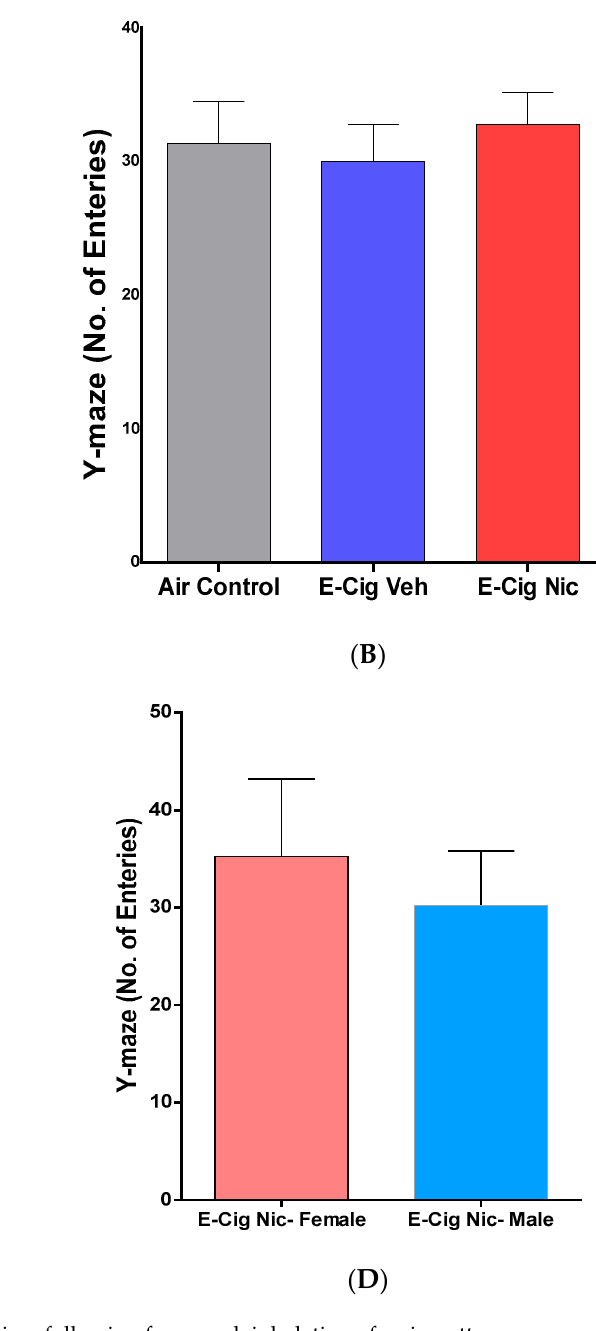
Figure 6. Spatial memory behaviors following four-week inhalation of e-cigarette vapors containing nicotine. ( A ) Percentage of spontaneous alterations (%SAP) (n = 8/group, 4F and 4M). ( B ) Number of entries into Y-maze arms (n = 8/group, 4F and 4M). ( C ) %SAP in female and male mice of the E-cig Nic group (n = 4/group). ( D ) Number of entries into Y-maze arms in female and male mice of the E-cig Nic group (n = 4/group). One-way analysis of variance (ANOVA) did not show significant differences between the three groups. Unpaired t test also did not reveal any significant changes in the Y maze parameters (%SAP and number of entries) between male and female of E-cig Nic group. Data are presented as mean ± SEM. E-cig, electronic cigarette; E-cig Veh, electronic cigarette with vehicle only; E-cig Nic, electronic cigarette with nicotine; F, female; M, male.